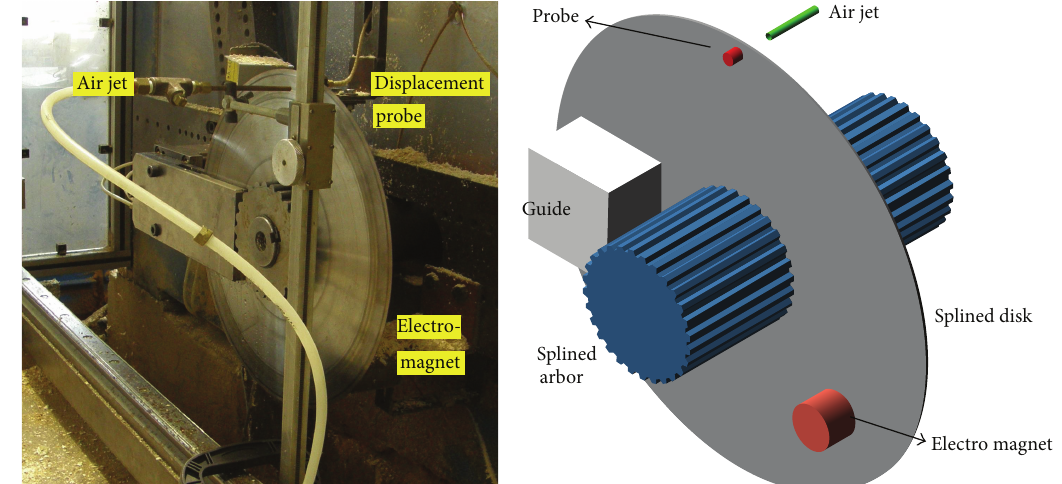
Figure 1: Experimental idling tests setup.